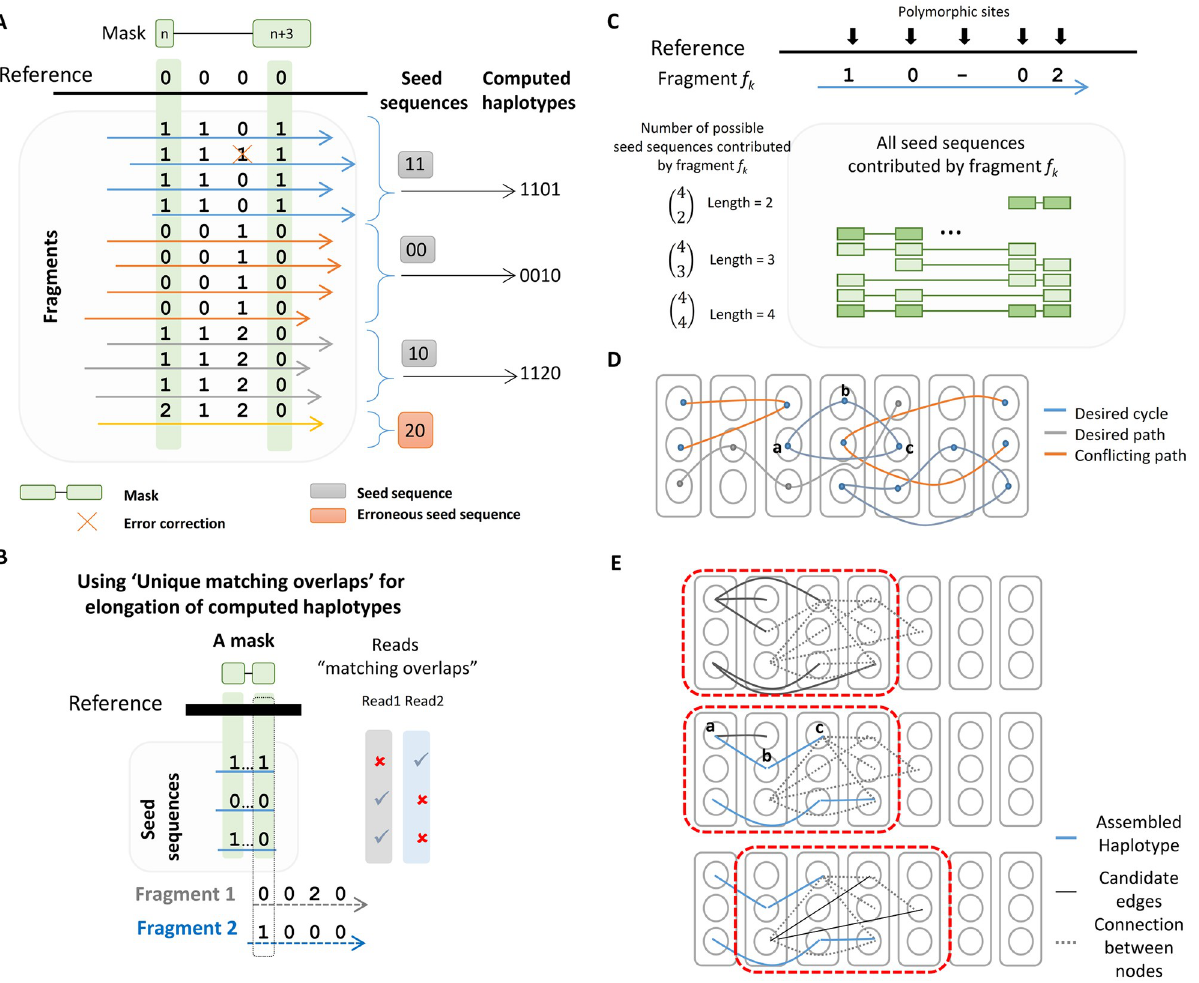
Fig 2. Ranbow’s main processing steps. (A) depicts a schematic view of how one mask results in its haplotype segments. The seed sequences cluster the fragments according to the variants they carry. In this figure, there are three clusters; each constructs one haplotype segment. The haplotype segments are supported with four, four, and three fragments, respectively (blue, red, and green fragments). The purple fragment gets discarded because it is detected as an erroneous fragment (see text). (B) A unique matching overlap of Fragment 2 and a haplotype block in a triploid genome. Fragment 1 has two matching and one mismatching overlap. This violates the unique match overlap rule. Fragment 2 has one matching and two mismatching overlaps meaning that Fragment 2 can be merged with the first haplotype unambiguously. (C) One fragment covering four polymorphic sites contributes eleven seed sequences. The seed sequences of length two, three, and four are shown in the panel in different colors. (D) A schematic view of the multi-partite graph and desired and conflicting cycles and paths. (E) Schematic view of the steps for constructing haplotypes from desired cycles of length three. A sliding window of length four is depicted in red. Solid gray lines represent the edges starting from the leftmost block of a sliding window. The blue edges are the newly formed haplotypes. The candidate edges at each step are checked to find if they construct a triangle or not. The most supported triangle at each step is converted to one haplotype